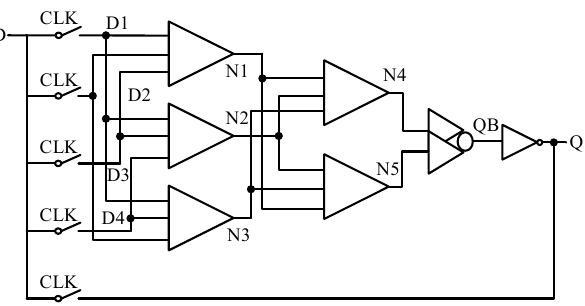
Figure 5. Latch schematic for TNUTL.